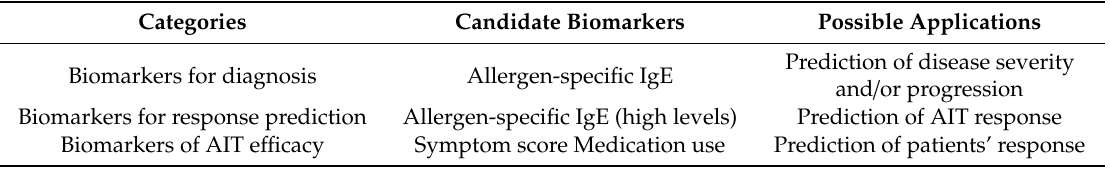
Table 2. Pragmatical biomarkers for allergen immunotherapy